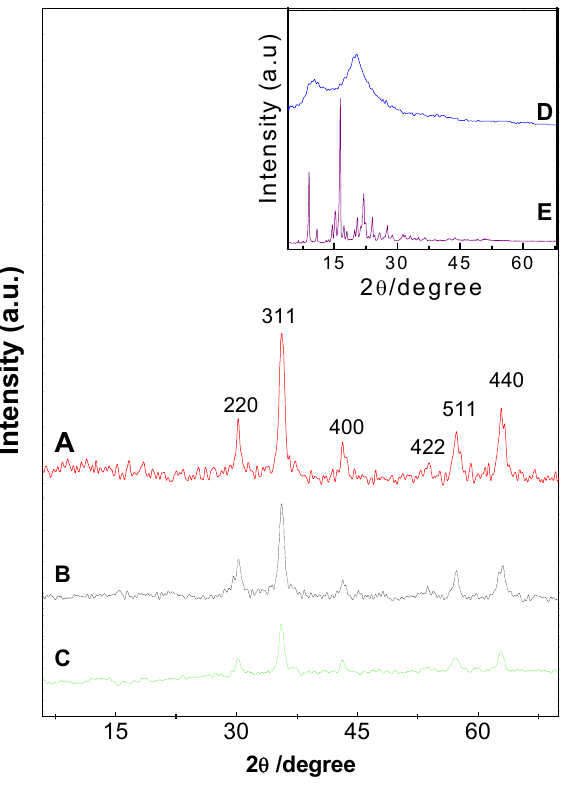
O nanoparticles ( A ) iron oxide coated with chitosan (FC) Figure 1. XRD patterns of Fe 3 4 ( B ); and iron oxide coated with chitosan-prindopril erbumine (FCPE) ( C ); Inset shows the X-ray diffraction patterns for the chitosan ( D ) and pure perindopril erbumine (PE) ( E